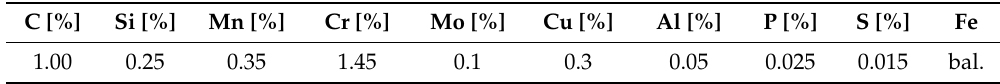
Table 2. Chemical composition of 100Cr6 bearing steel.